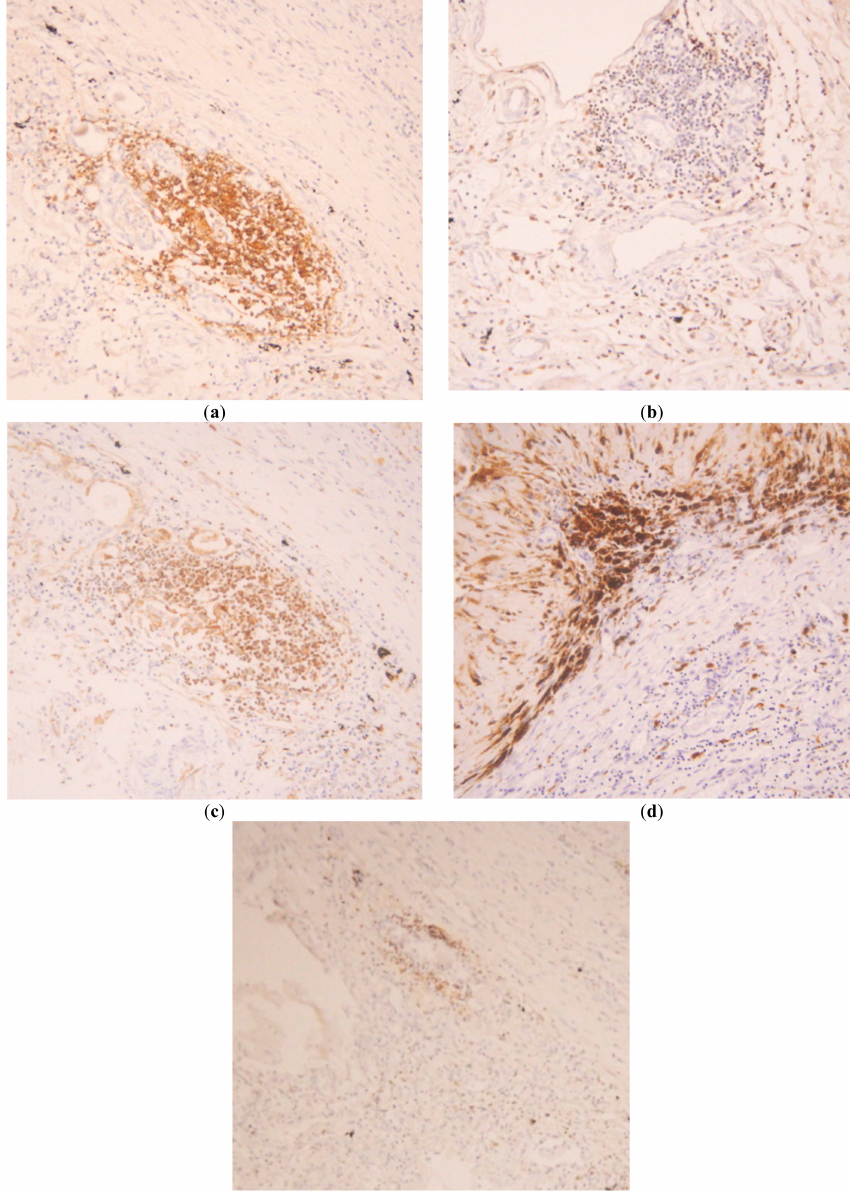
Figure 2. Representative pictures of the immunohistochemistry of the lung. Positive cells are colored brown. ( a ) Abundant T cells CD3 + in perivascular location; ( b ) Scarce CD4 + T cells; ( c ) Abundant HLA-DR + T cells. Most of the T cells were activated through the expression of this cell marker; ( d ) abundant CD68 + cells (macrophages) a ff ecting alveoli and interstice; ( e ) Scarce CD20 + cells (B cells), located in the perivascular